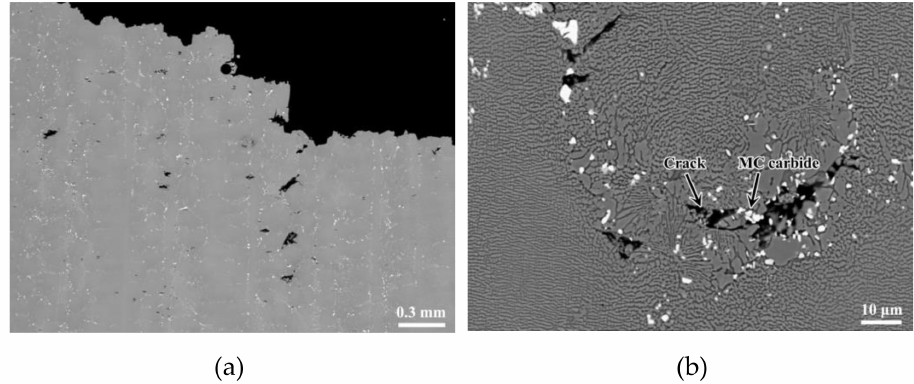
Figure 3. SEM-BSE images of the stress rupture voids at a lower magnification ( a ) and a higher magnification ( b ) along the longitudinal sections in the specimens under 980 ◦ C/70 MPa after being exposed to 1020 ◦ C/70 MPa for 500